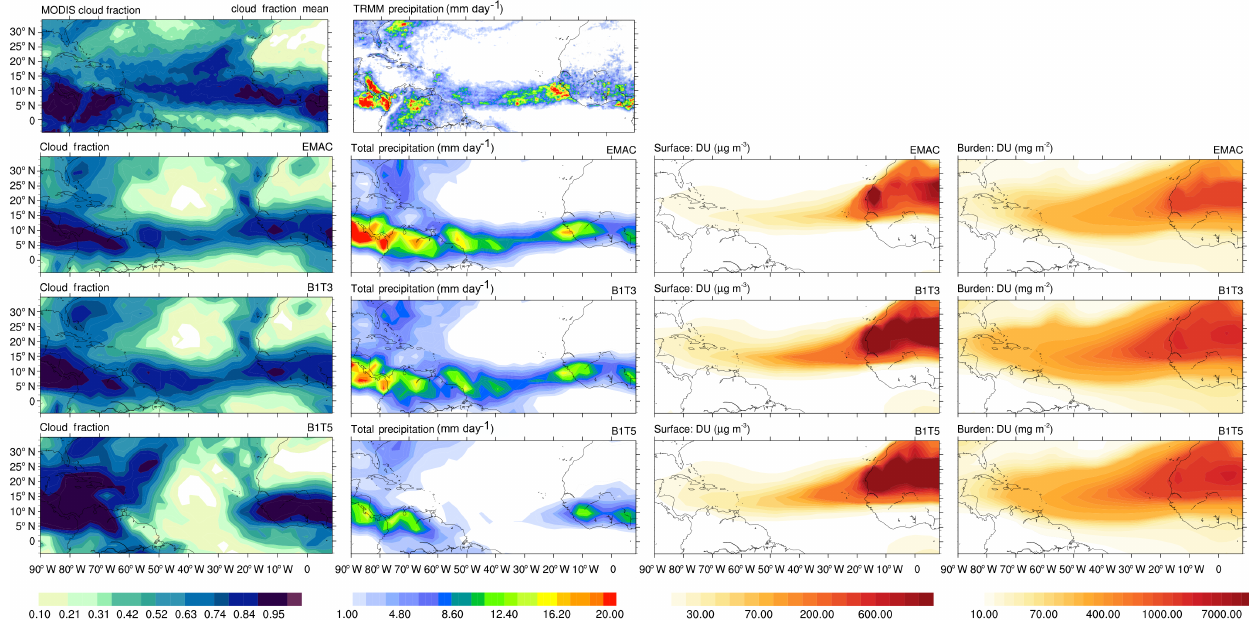
Figure 10. MODIS cloud fraction and TRMM precipitation (top; July 2009 monthly mean). EMAC results (below; from left to right) for the cloud fraction, precipitation, surface dust concentration and dust burden for the different convection schemes (second to fourth row) highlighted in Table 3. The model precipitation and cloud cover agree for our EMAC setup best with the TRMM and MODIS observations with the TIEDTKE (B1T3) and ECMWF (B1T5) convection